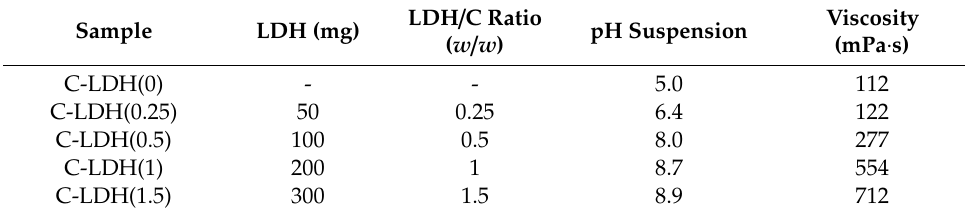
Table 1. Formulation parameters and viscosity of various suspensions of LDH added to a 2% (w / w) solution of C (pH = 5 at 25 ◦